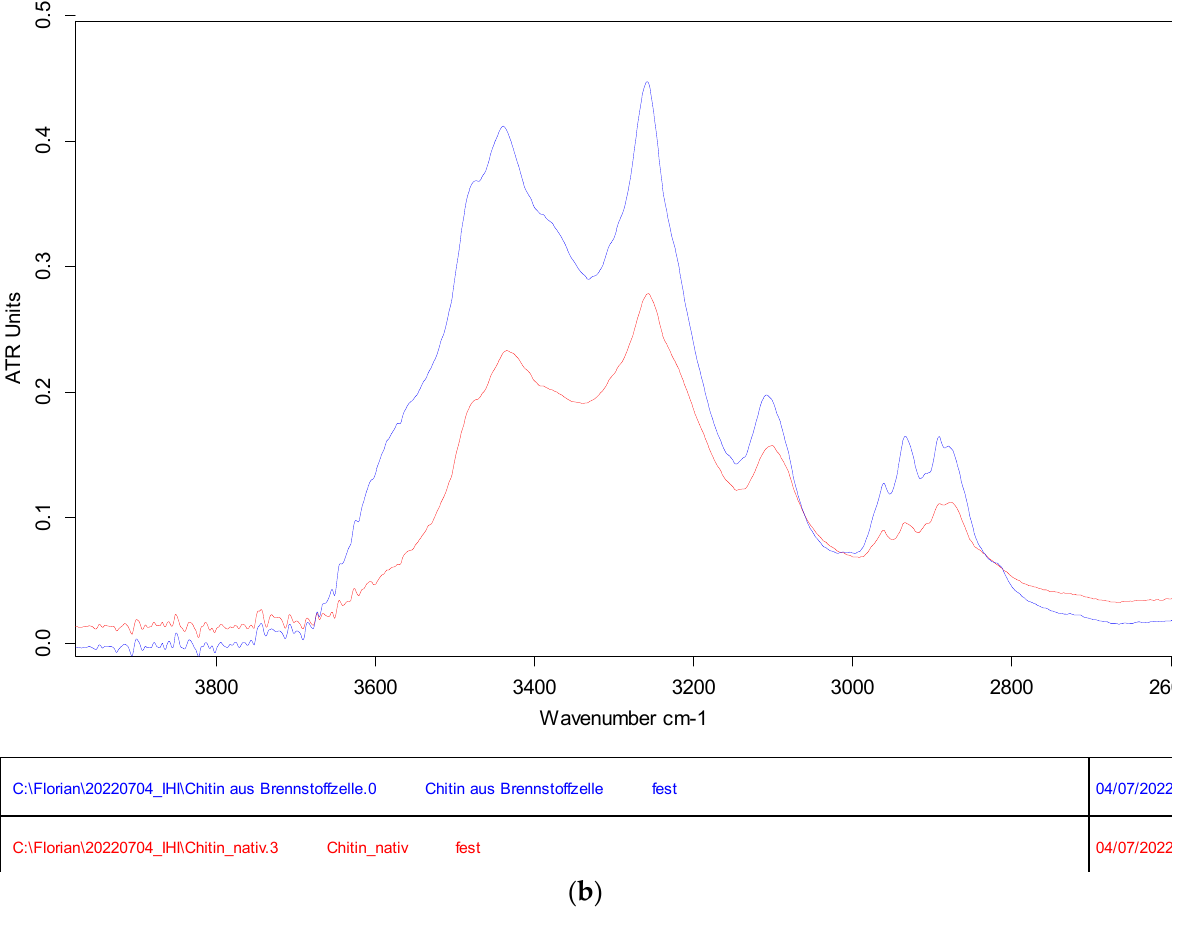
Figure 8. ( a ): Native chitin (red) and its degradation after photooxidation mediated by Eu(III); spectral region 1950–1150 cm − 1 ( ≈ 5.1 - 8.7 µm). ( b ): Native chitin from Pandalus borealis (Sigma-Aldrich) and its photooxidation product; spectral 2600 - 4000 cm − 1 . The intermediate range around 2200 cm − 1 could not be measured because there were absorption bands of the supporting diamond crystal. Spectra were taken by F.Prasse (Hochschule Zittau-Görlitz, Saxony). “Brennstoffzelle” means fuel cell.